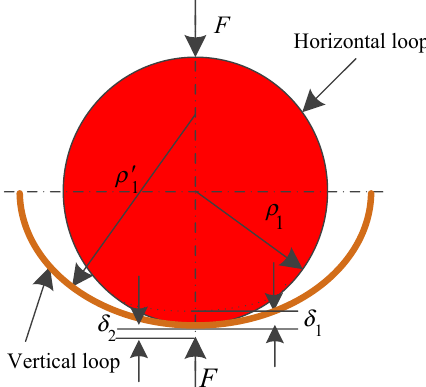
Figure 4. Diagram of local indentation deformations in the round link